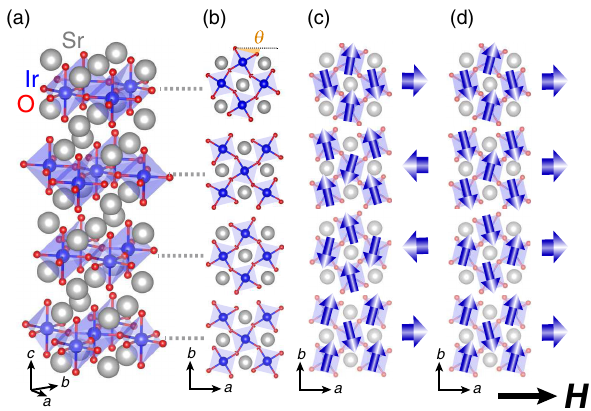
FIG. 2. (a) Crystal structure of Sr 2 IrO 4 . (b) Top view of each layer. The crystal has a tetragonal structure with corner sharing IrO 6 octahedra, which is rotated by θ ¼ 11 ° around the c axis. (c) AF-I ( þ −− þ ) magnetic structure. (d) AF-II ( þþþþ ) magnetic structure. Weak ferromagnetic moments are induced in the